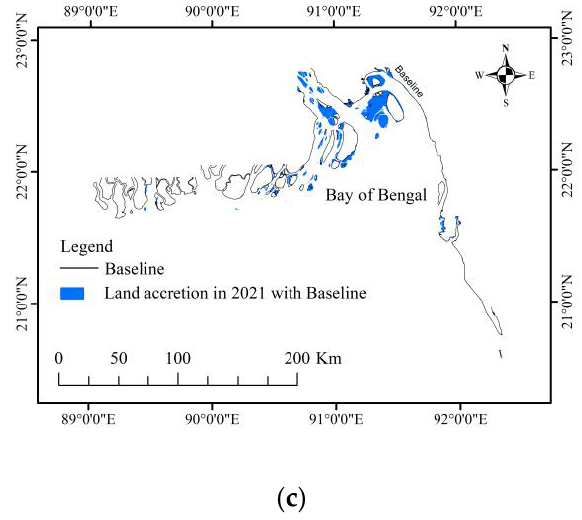
Figure 13. Land accretion along with the study baseline in the coastal region of Bangladesh (baseline to shoreline): ( a ) 1991, ( b ) 2006, and ( c ) 2021. Table 1. Accession of lands from baseline to shoreline.